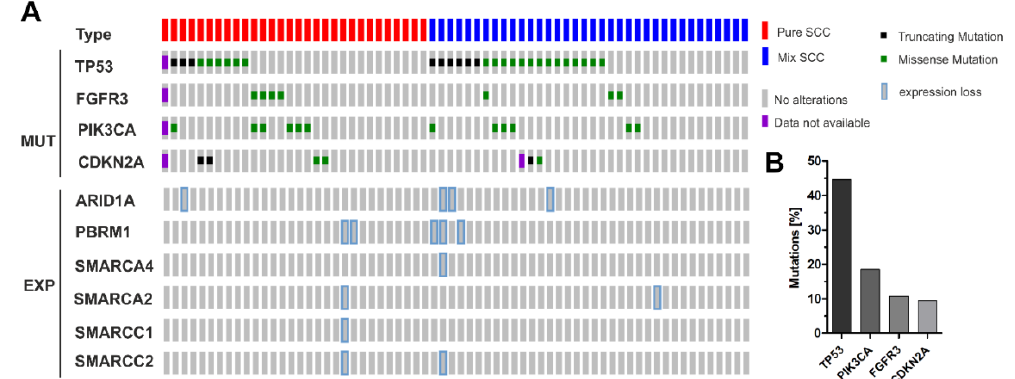
Figure 3. Expression loss of SWI / SNF subunits in sq-BLCA with known genetic driver mutations. ( A ) Upper lines: mutational spectrum of genes ( TP53, FGFR3, PIK3CA, CDKN2A ) potentially involved in bladder cancer development and progression (SCC: n = 30; MIX SCC: n = 36). TP53 was the most frequently mutated gene in pure SCC (9 / 29) as well as MIX-SCC (20 / 36), while FGFR3 (SCC: 4 / 29; MIX: 3 / 36) and CDKN2A (SCC: 4 / 29; MIX: 2 / 35) mutations were less abundant (SCC: 4 / 29; MIX: 3 / 36). PIK3CA driver mutations were observed in 6 / 29 (SCC) and in 6 / 36 (MIX) tumors. Lower lines: corresponding expression loss of subunits of the SWI / SNF complex. MUT: mutations; EXP: expression. ( B ) Overall mutational frequencies of analyzed driver genes. Table 3. Clinico-pathological parameters and known driver mutations in relation to ARID1A expression loss.